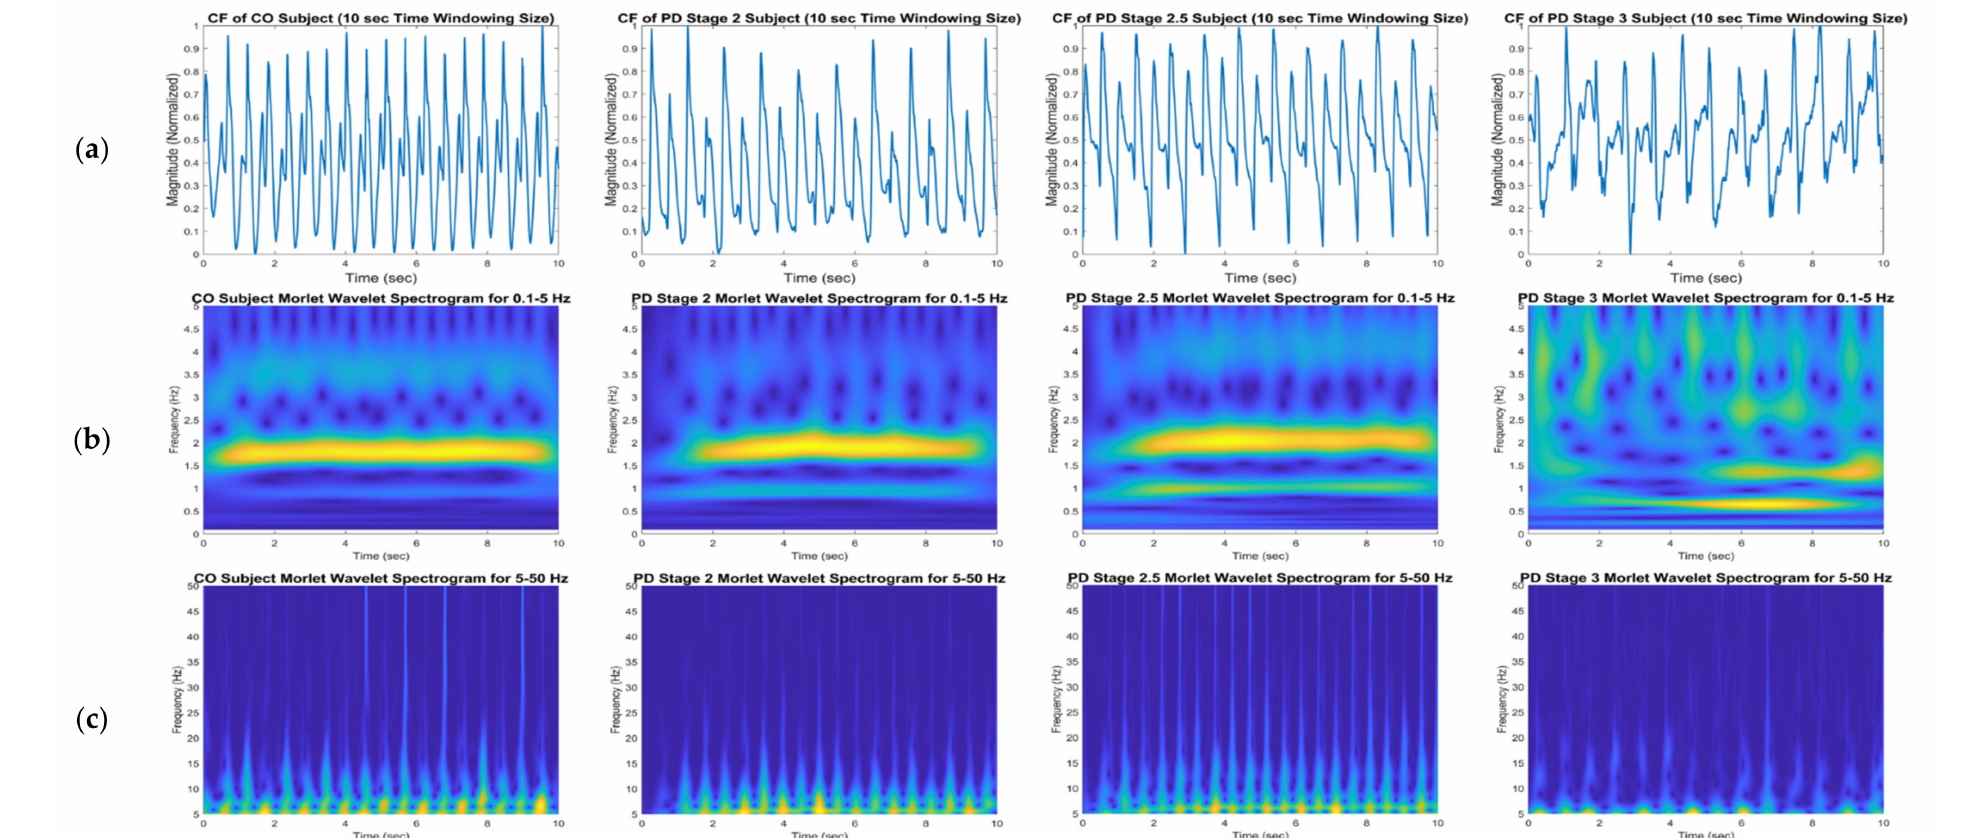
Figure 3. Time-frequency spectrograms using CWT of the first 10 s CF vGRF signals of CO, PD Stage 2, PD Stage 2.5, and PD Stage 3 subjects in a 10 s time window size from Ga [21] dataset: ( a ) original vGRF signal, ( b ) 0.1–5 Hz time-frequency spectrogram, and ( c ) 5–50 Hz time-frequency